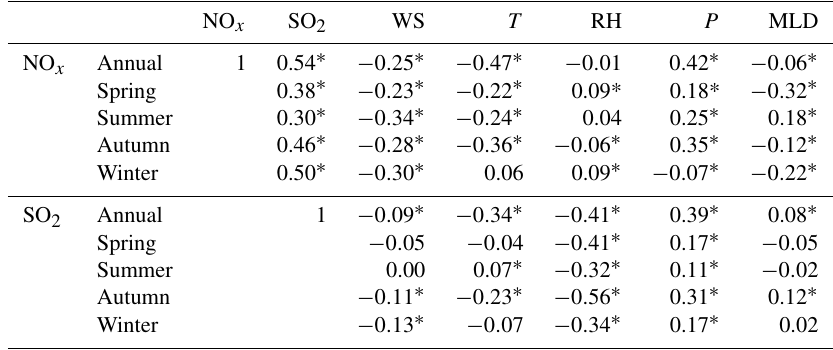
Figure 4. Annual average diurnal variations in NO x ( a , left axis) and in SO 2 ( b , left axis) at LAN and its surrounding cities ( a , NO x , right axis; b , SO 2 , left axis); seasonal average diurnal variations in NO x ( c , left axis) and SO 2 ( d , left axis) at LAN. The average diurnal mixed-layer depth (MLD; right axis) is also plotted in panel (b) . Table 3. Pearson correlations among NO x , SO 2 and meteorological elements (daily average